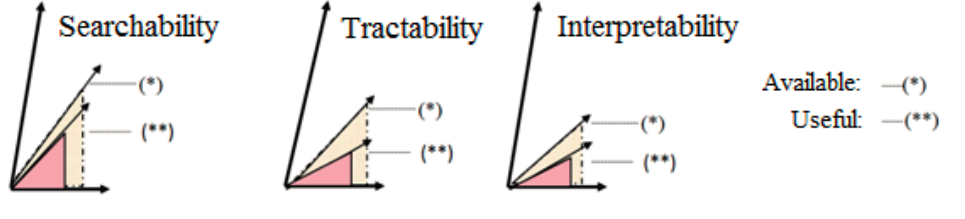
Figure 1. The three main components of information